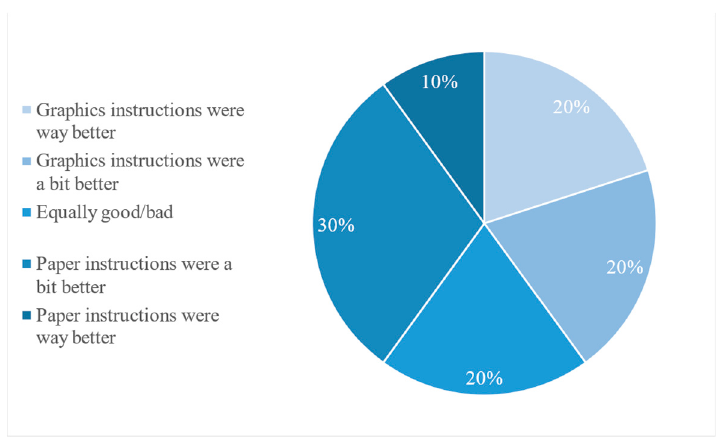
Figure 17. Answers to the question “Compared to using paper instructions, how did you find it getting graphics instructions?”.